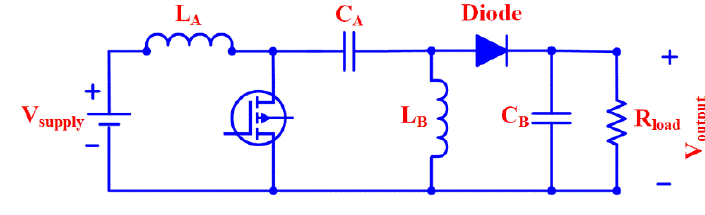
Figure 5. SEPIC converter equivalent circuit. Table 1. SEPIC converter parameter.